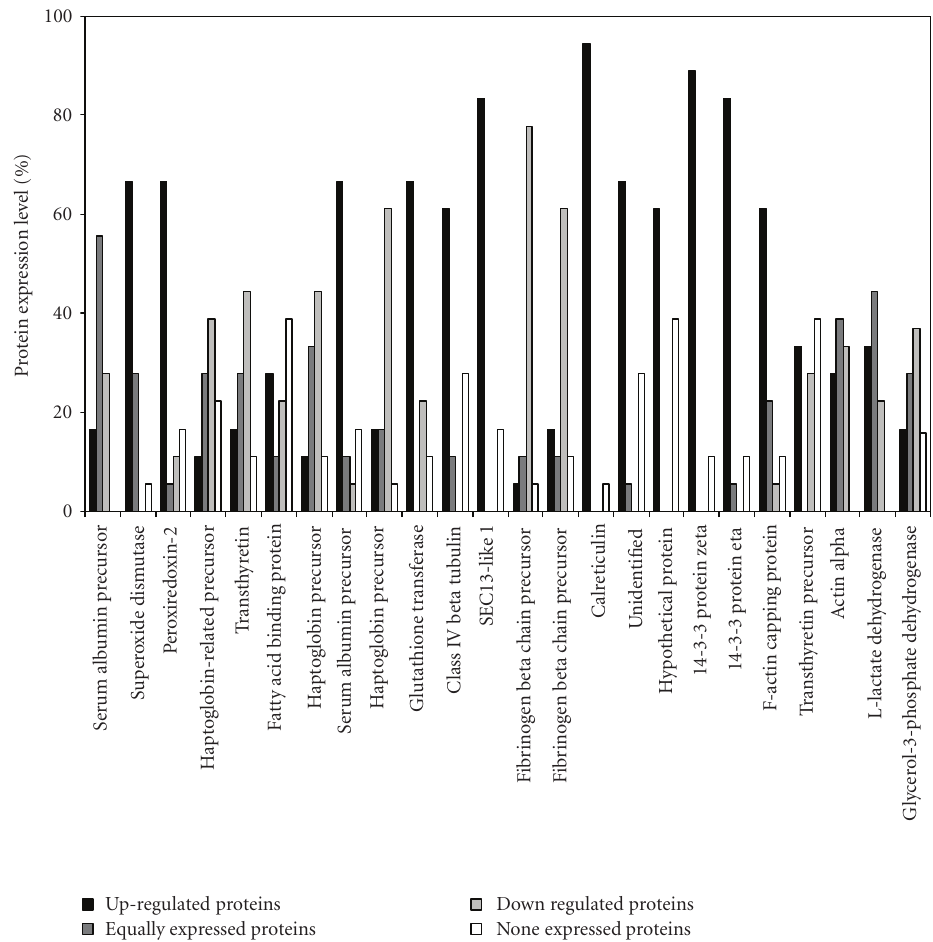
Figure 5: Distribution of proteins in TRIS extracts of all patients. The expression of proteins was defined as upregulation, downregulation, equal expression, and nonexpression in each